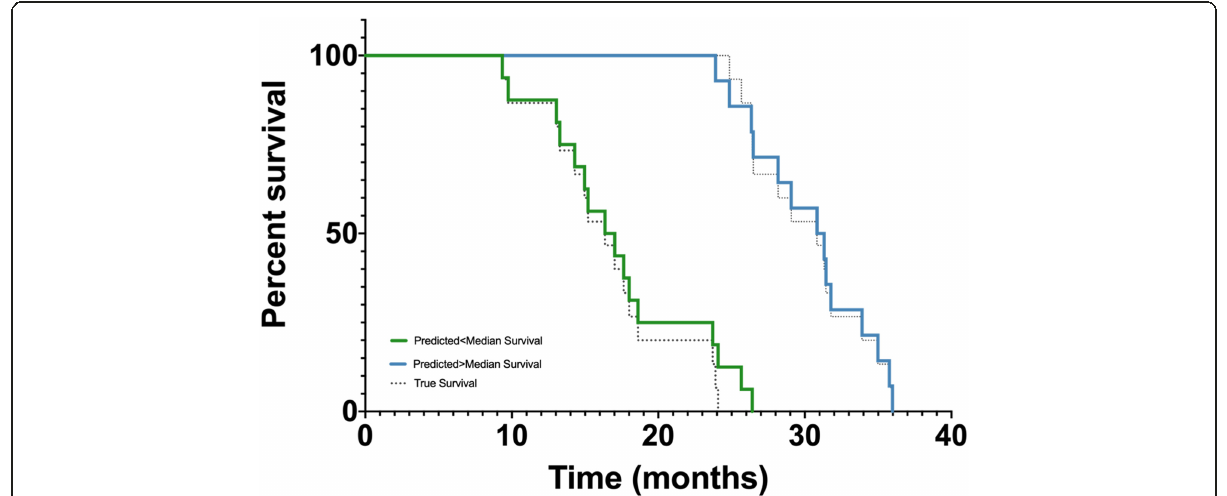
Fig. 3 Kaplan-Meier curves showing the predicted survival (blue and green curves) and the true survival (dotted curves) for patients in the